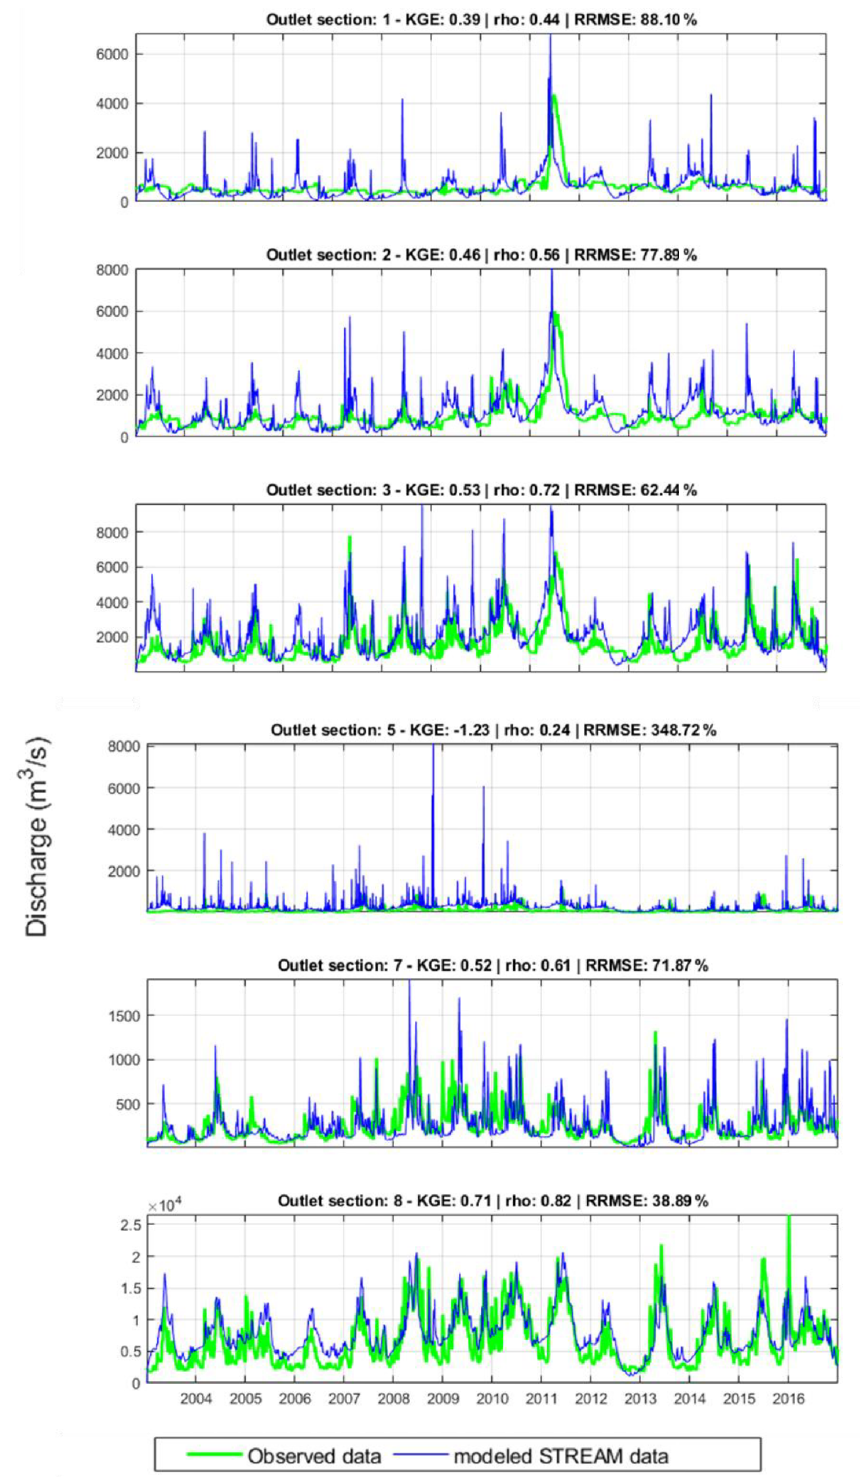
Figure 5. Comparison between observed and modeled river discharge time series over the gauged sections not used in the calibration phase. Performance scores at the top of each plot refer to the entire study period